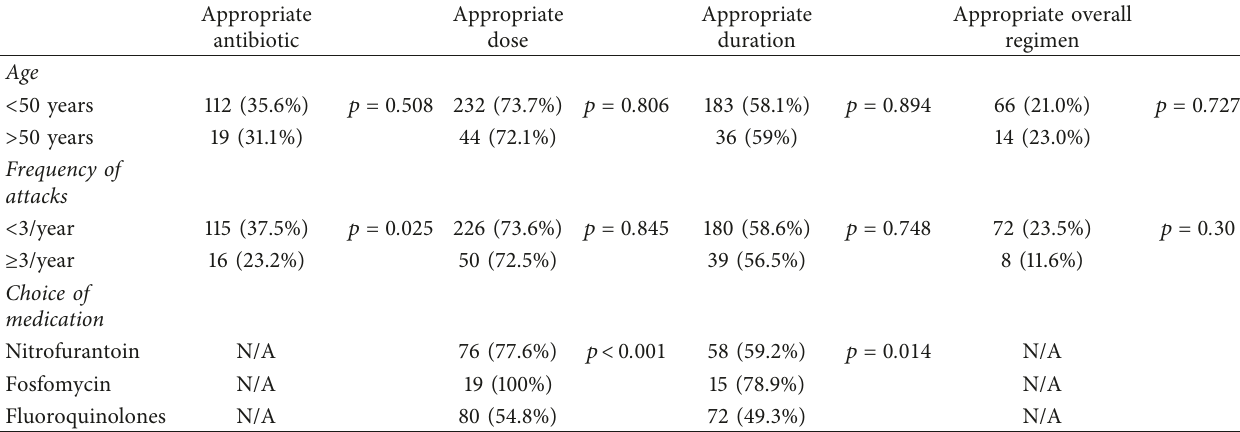
Table 3: Bivariate